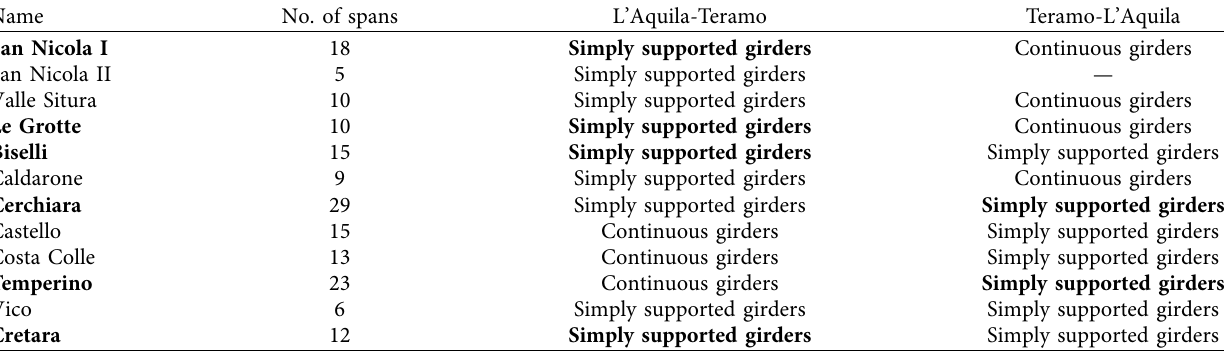
Table 3: Description of the investigated